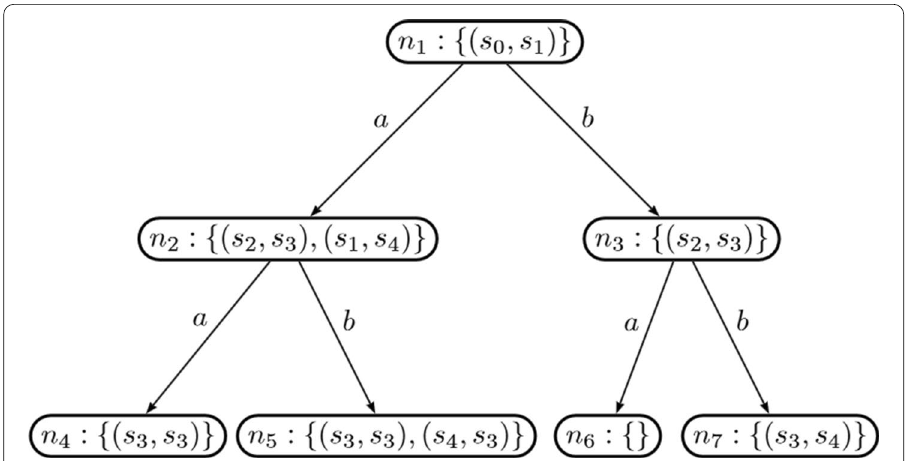
Fig. 2 The truncated successor tree of M / s 0 ∩ M / s